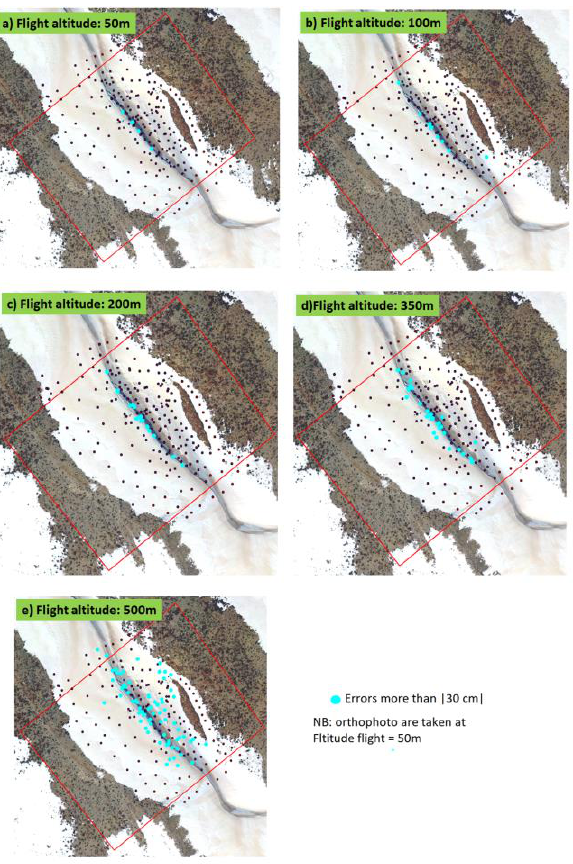
Figure A5: location of error above |30 cm| as per each flight altitude